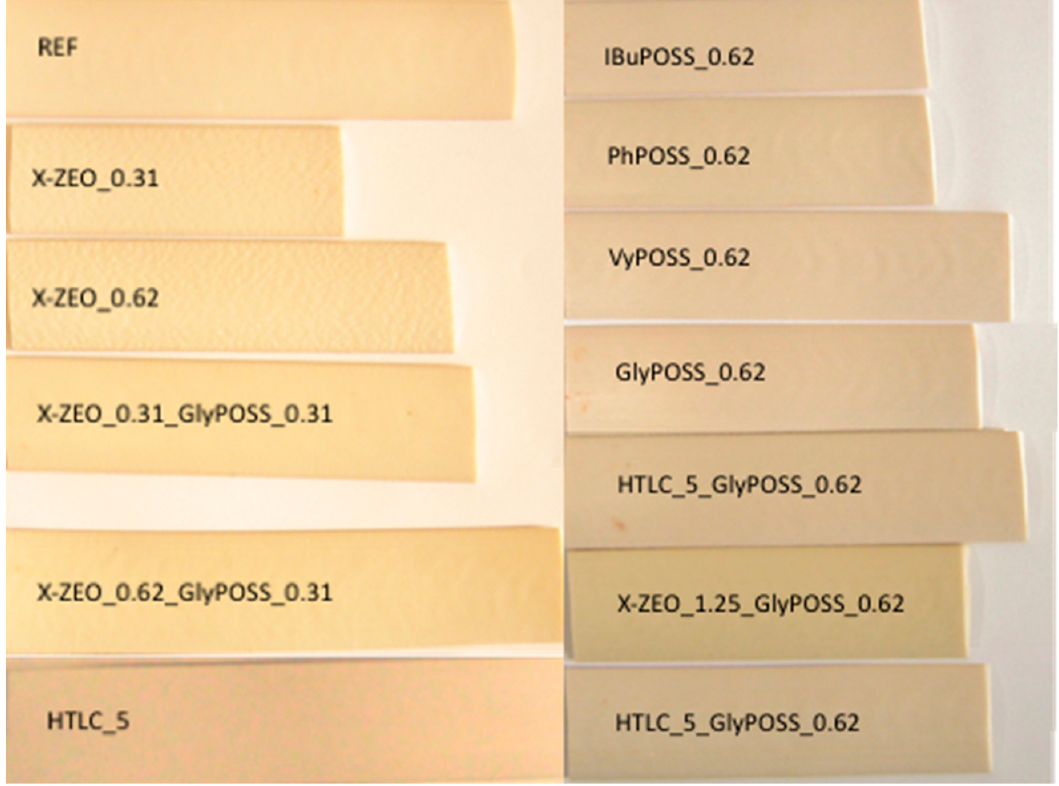
Figure 2. Picture of nanocomposite P-PVC formulation ribbons.